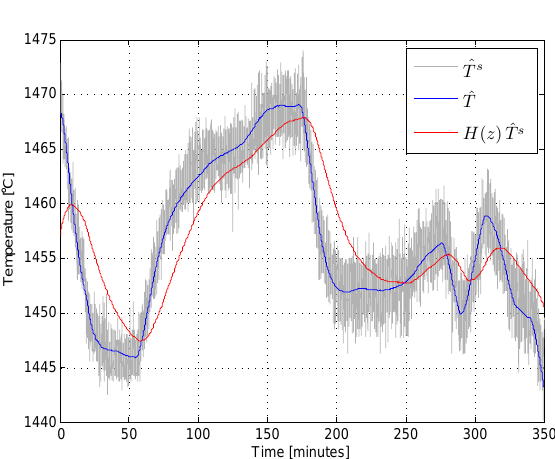
Figure 21: The output of the sensor fusion algorithm, ˆ T , and the lowpass-filtered silicon pyrom- eter, H ( z ) ˆ T s , for cut-off frequency ω c = 9 . 6 10 − 4 ×